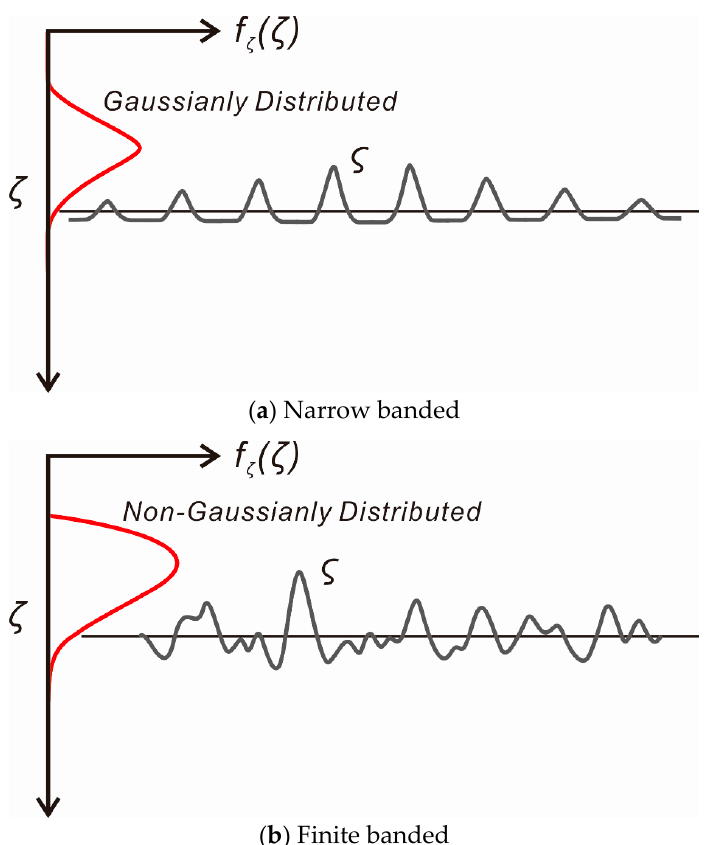
Figure 9. Schematic sketch of the effect of bandwidth on the statistical distribution of nonlinear random waves (reproduced from Park and Cho [17]).